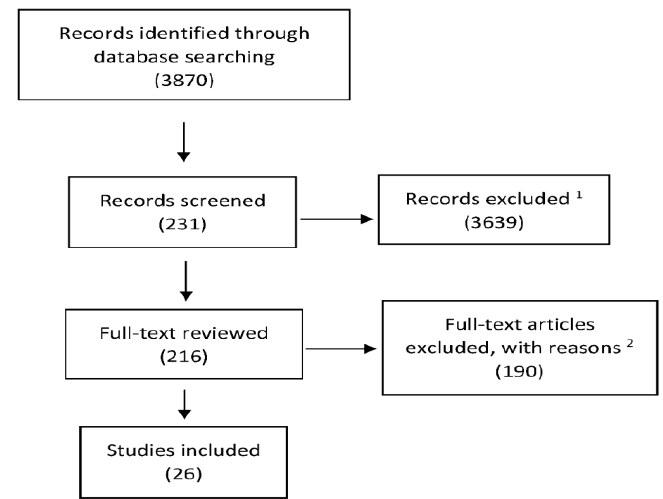
Figure 1. Study selection process. 1 Exclusion criteria included non-human subjects, non-primary research, lack of a primary outcome related to hypovitaminosis D and / or bone health and / or secondary hyperparathyroidism, abstract-only publication, or non-English language. 2 Additional exclusion criteria for full texts included a pediatric population, diabetic population, case reports, and failure to measure baseline and post-treatment 25(OH)D levels. We also excluded papers focused on cardiovascular diseases and overall chronic human disease.